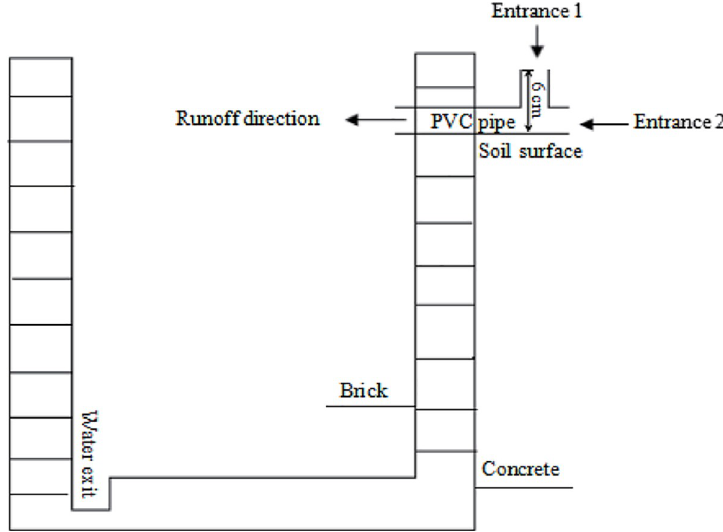
Fig 1. Device for the collection of runoff water in experimental plots in 2018. Notes: Entrance 1 for water into tank during irrigation period; Entrance 2 for water into tank during paddy drying or fallow